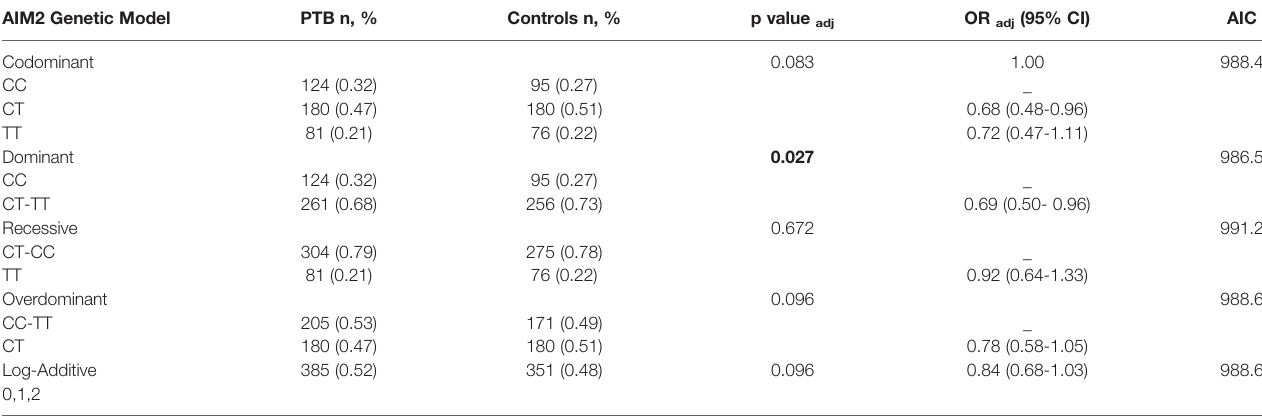
TABLE 1 | Genetic models of association SNV rs1103577 of AIM2 gene adjusted for sex and age in patients with pulmonary tuberculosis (PTB) and healthy control. AIM2 Genetic